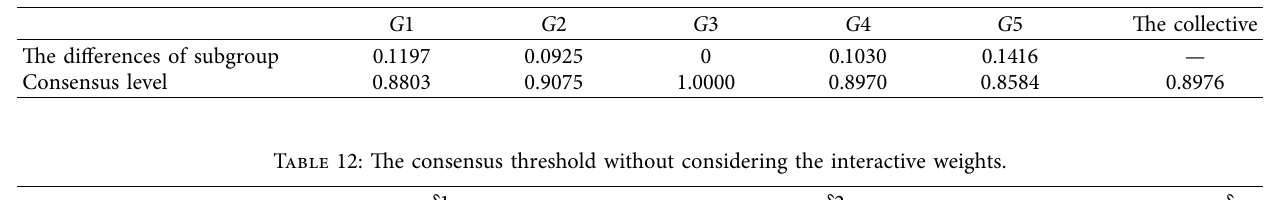
Table 11: .e consensus level without considering the interactive weights.